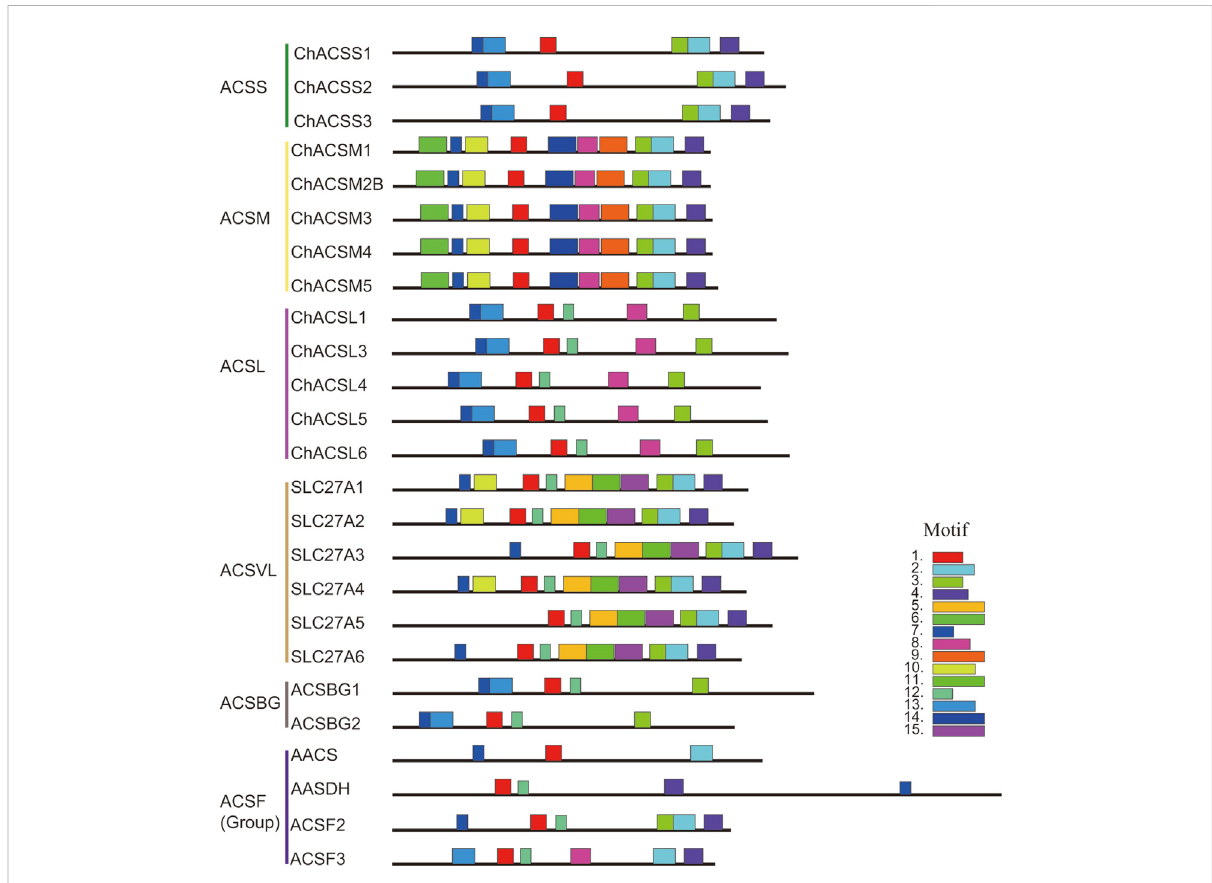
FIGURE 5 Motif distribution in ACS genes from goat. Legends: Motifs were predicted using the MEME web server (https://www.swissmodel.expasy.org/). The motifs are represented by different colors. The length of each box in the fi gure does not represent the actual motif